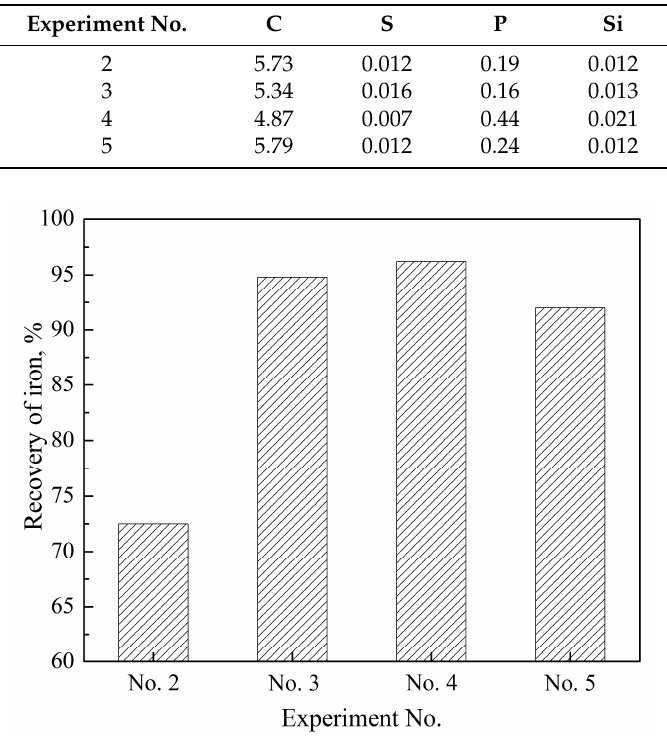
Figure 7. Picture of materials inside the crucible after smelting separation. Table 4. Composition of the metallic phase after smelting separation (mass%).